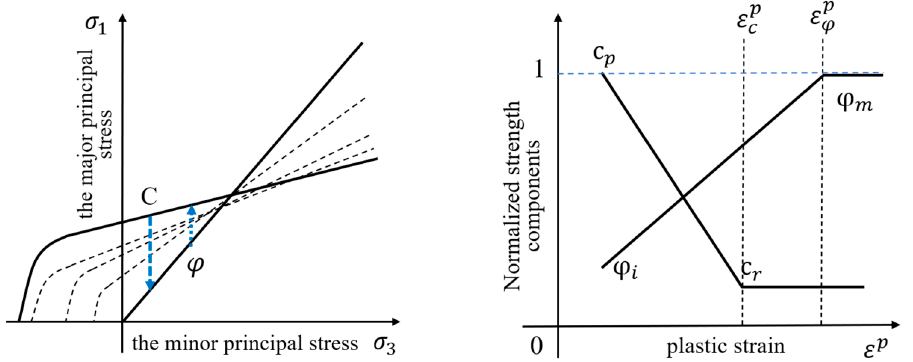
Figure 7. Simplified schematic illustration of typical CWFS model usage [51].